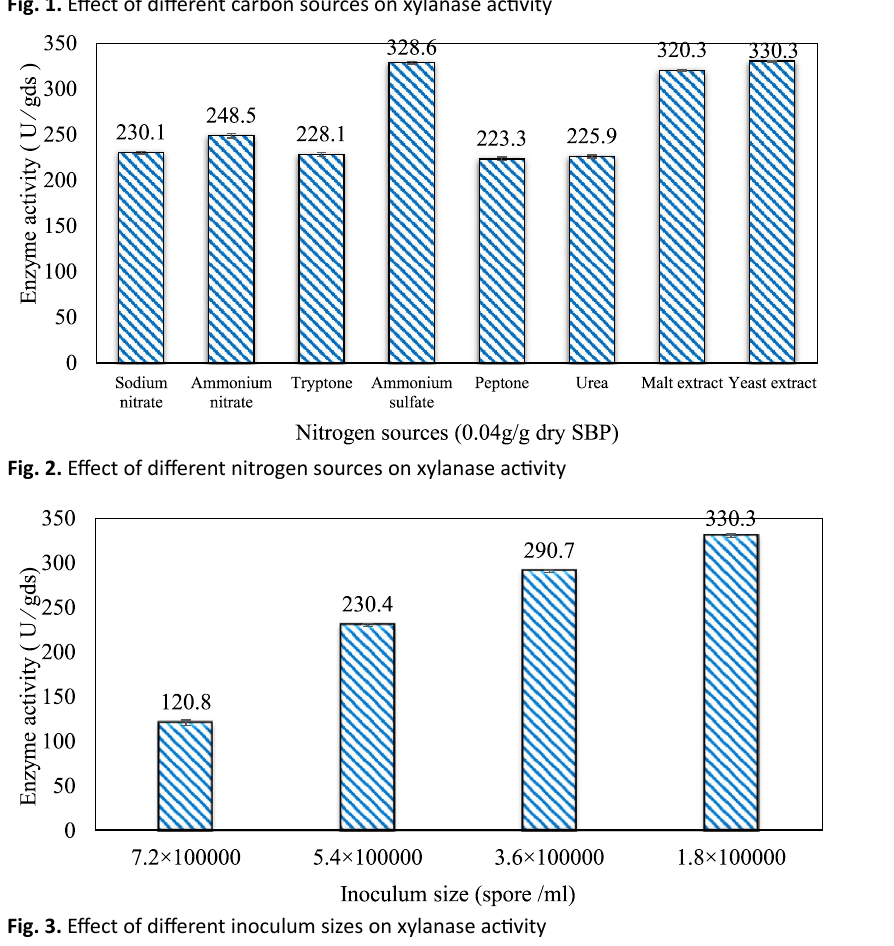
Fig. 3. Effect of different inoculum sizes on xylanase activity